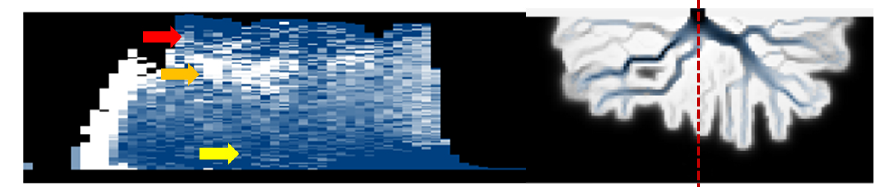
Figure 11. Stratigraphy slice in the dip direction of run 4 (30% sand input). Note the layering of coarse and fine grains over time. Yellow arrow points to the bottom layer that accumulates fine grains at the bottom set of the delta; orange arrow points to the coarse grain layer deposited by channels that used to be active at that location; the two together show the classic “coarsening-up” pattern in stratigraphy. The red arrow points to the fine grains deposited after the channels are abandoned.